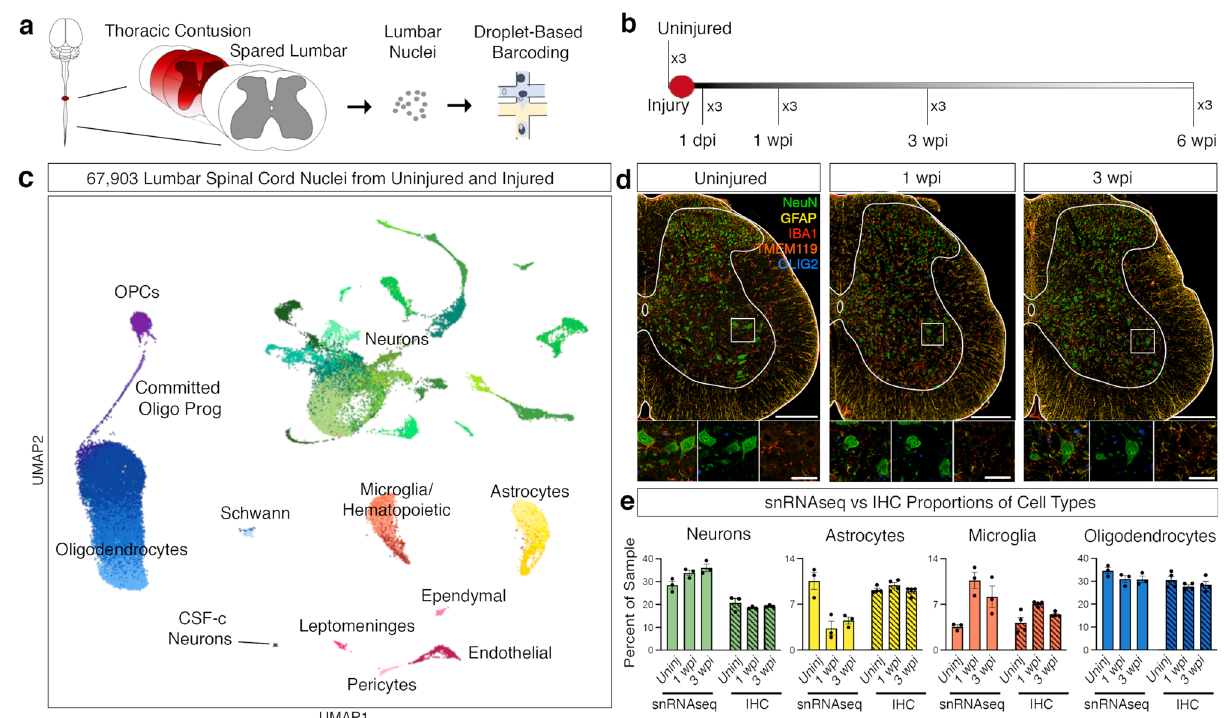
Fig. 1 | Single nucleus RNA sequencing ofthe lumbarspinalcordafter thoracic contusion. a Schematics depicting the experimental design for snRNA-seq, showingtheinjuredthoraciccordandlumbarcord(withdarkredrepresentingthe lesion) as well as nuclei isolation from the intact lumbar cord followed by droplet- based barcoding for single nucleus RNA sequencing. b Top, an overview of experimental design for injury and tissue collection. The lumbar spinal cord of three animals from each time point: uninjured, 1 dpi (day post injury), 1 wpi (week post injury), 3 wpi, and 6 wpi. c Uniform manifold approximation and projection (UMAP) visualization of 67,903 nuclei from uninjured and injured lumbar spinal cords, revealing 9 classes and 39 subtypes. Colored by green (neurons), yellow,